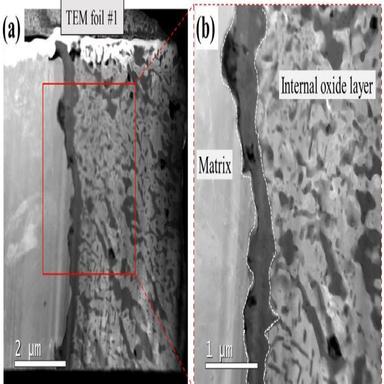
(a) TEM foil #1 and (b) TEM HAADF image at the matrix-internal oxide layer interface of T91 after exposure in SCW at 600 °C for 1500 h.